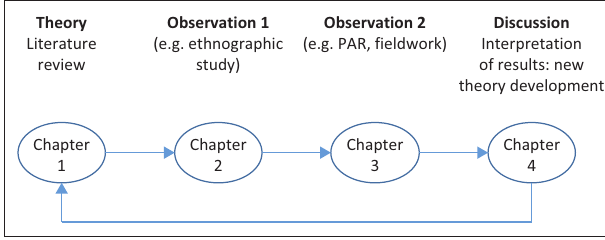
FIGURE 5: Theory in qualitative research designs (inductive).